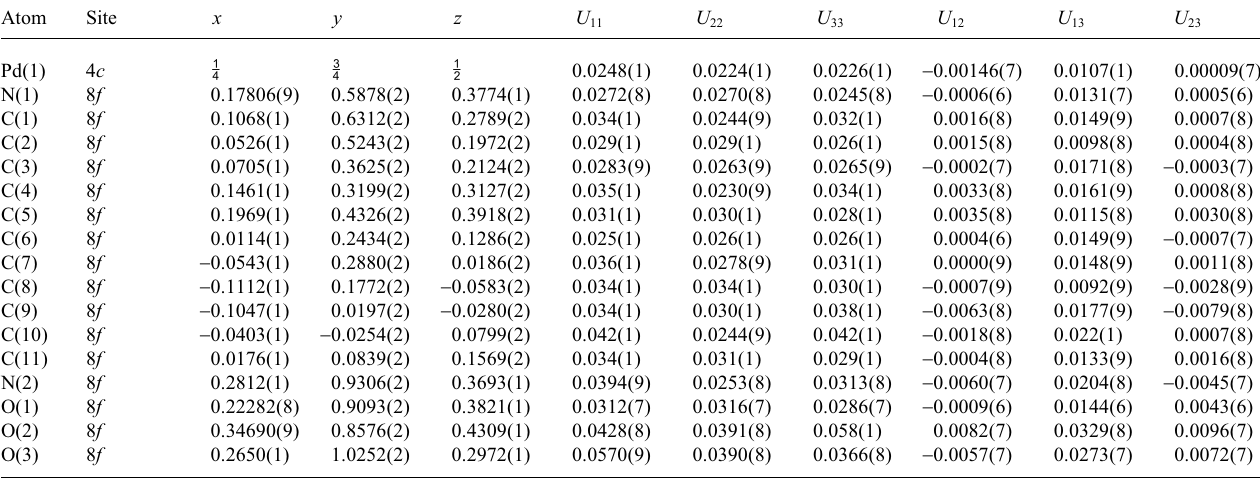
Table 3. Atomic coordinates and displacement parameters (in Å 2 )